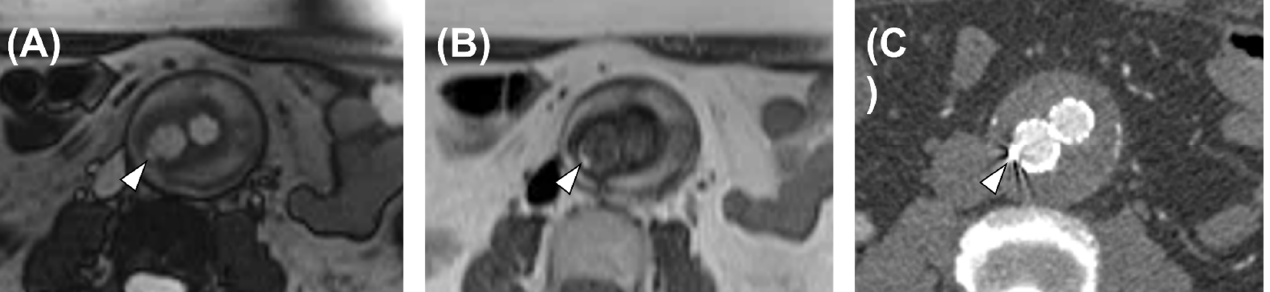
The contingency table is reported in Table 3